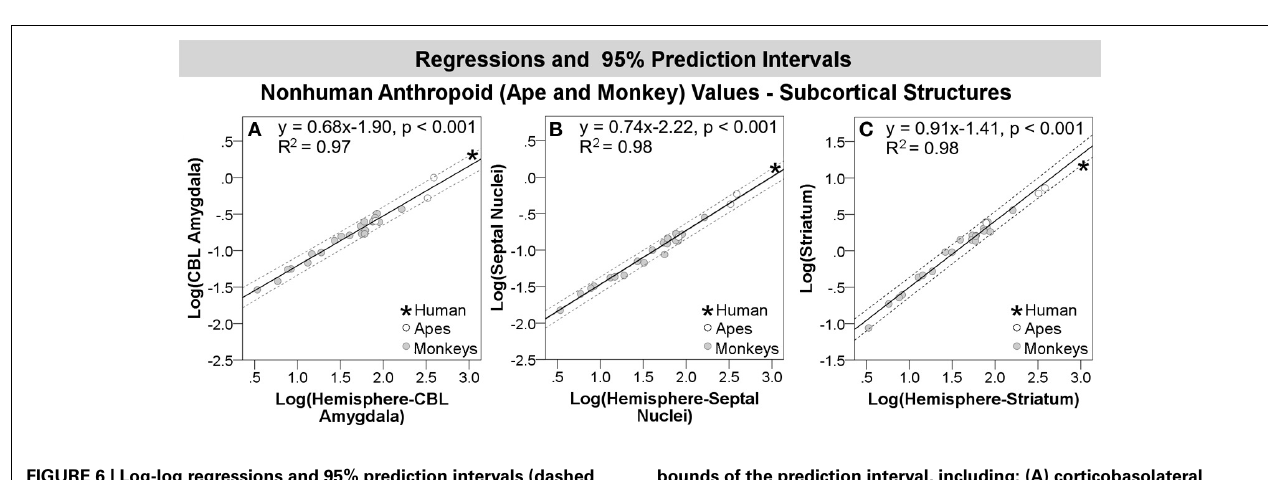
significance in statistical analyses, including: (A) hippocampus, (B) lateral amygdaloid nucleus, and (C) central amygdaloid nucleus.